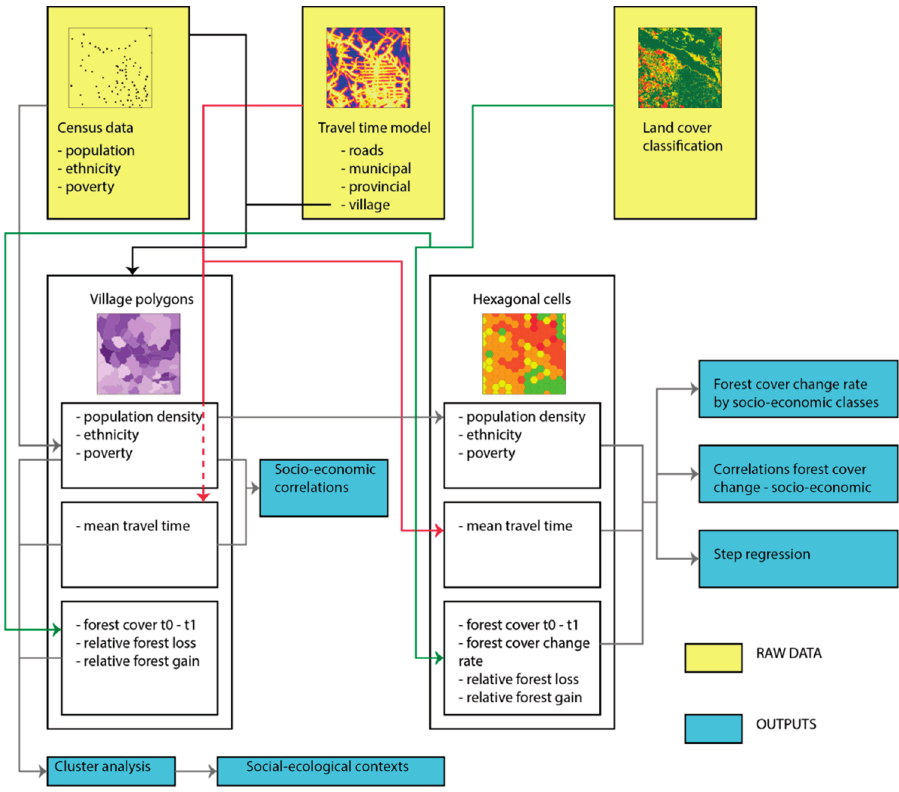
Figure 2. Methodological